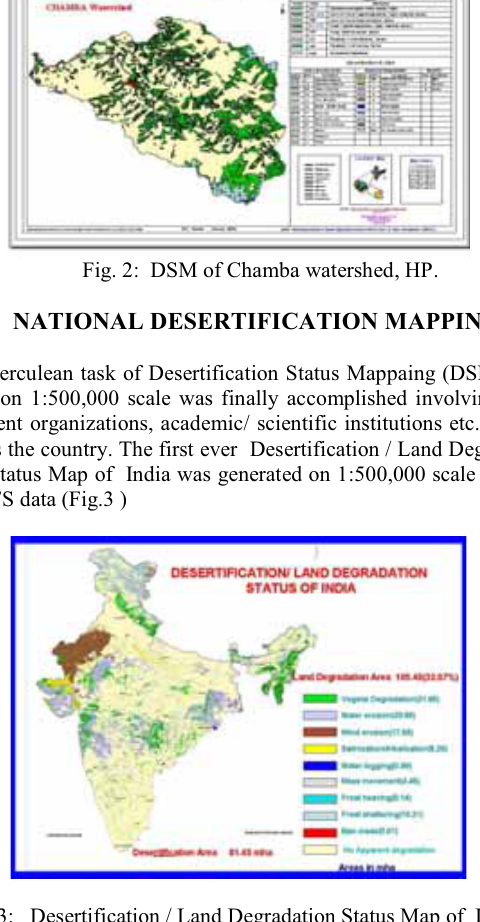
Fig. 3: Desertification / Land Degradation Status Map of India